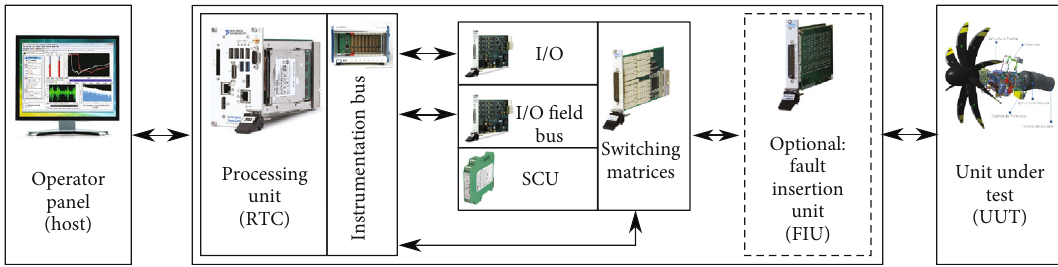
Figure 18: Veri fi cation equipment with a commutation matrix.